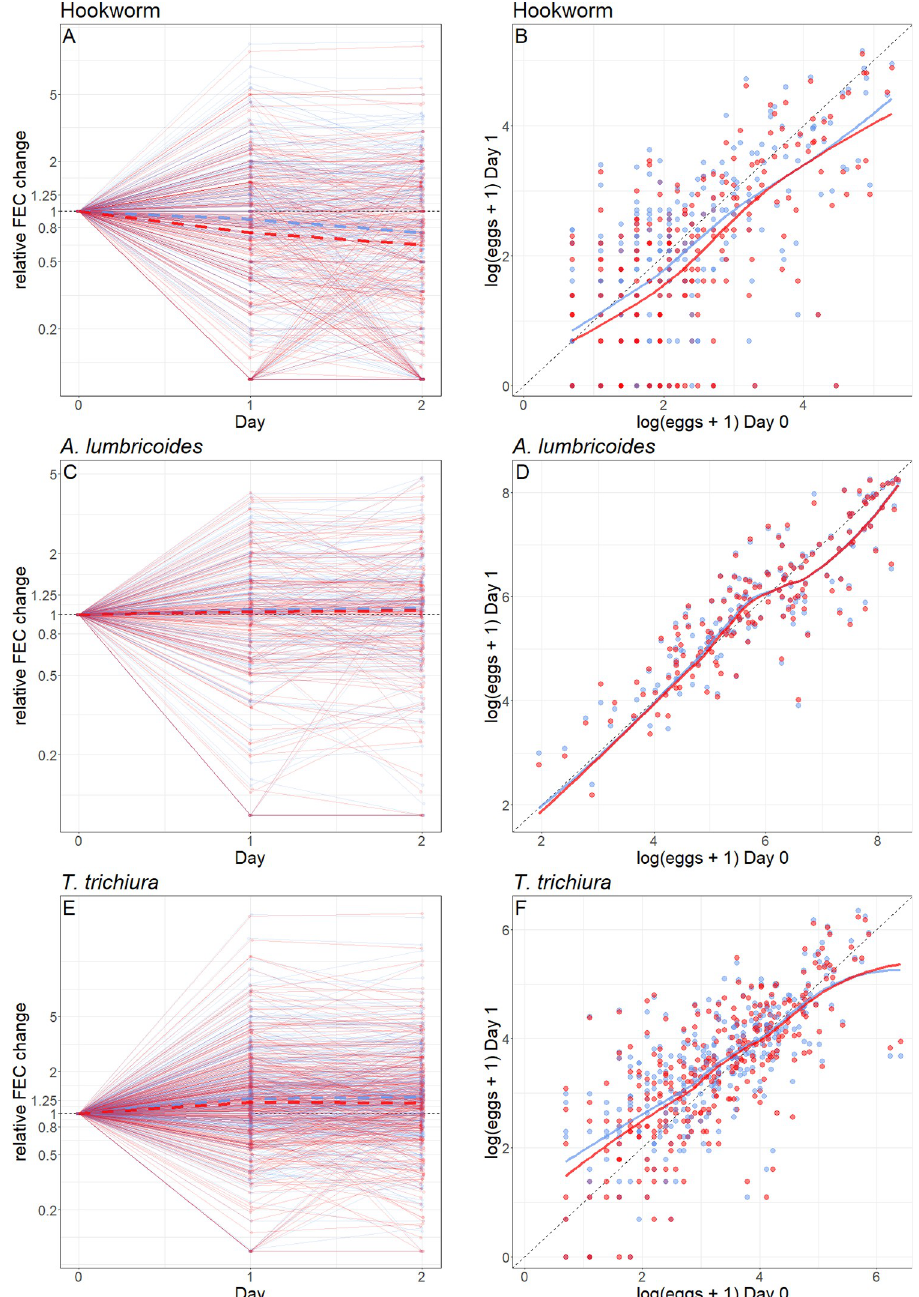
Fig 5. Whole sample storing experiment: Relative fecal egg counts (FEC) change over time for (A) hookworm (n = 259), (C) Ascaris lumbricoides (n = 163), (E) Trichuris trichiura (n = 313) and absolute FEC numbers and relative FEC change between day 0 and day 1 for hookworm (B), Ascaris lumbricoides (D) and Trichuris trichiura (F). For A, C and E: Dashed line = median. For B, D and F: Line = mean. Blue = refrigerator temperature, red = room temperature, A . lumbricoides = Ascaris lumbricoides , T . trichiura = Trichuris trichiura .